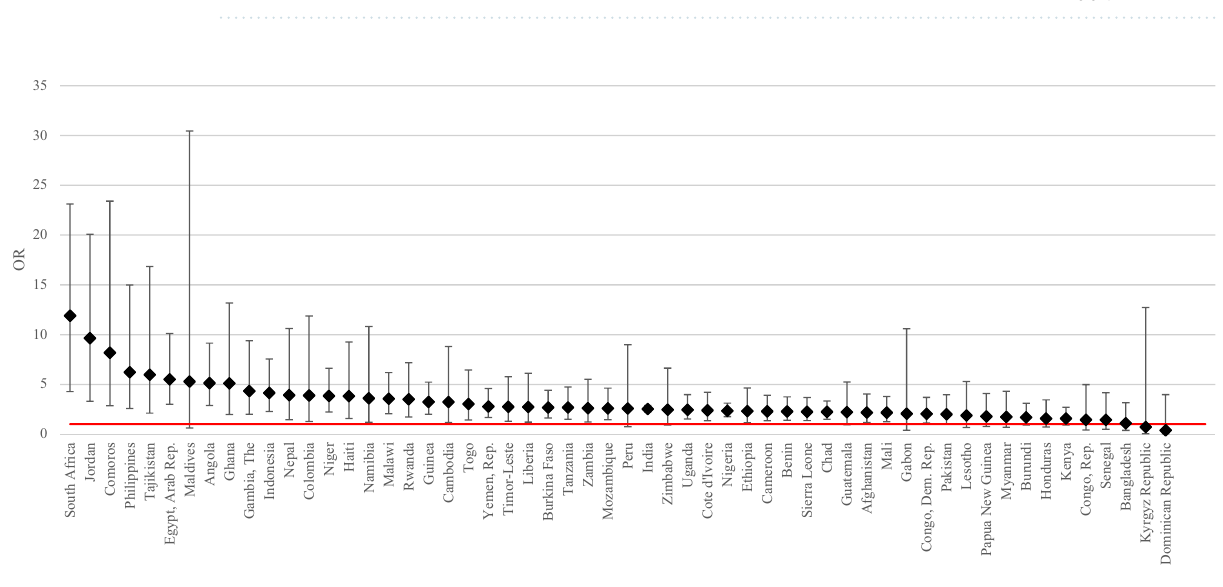
UOR − FAOR ∗ 100 . UOR − 1